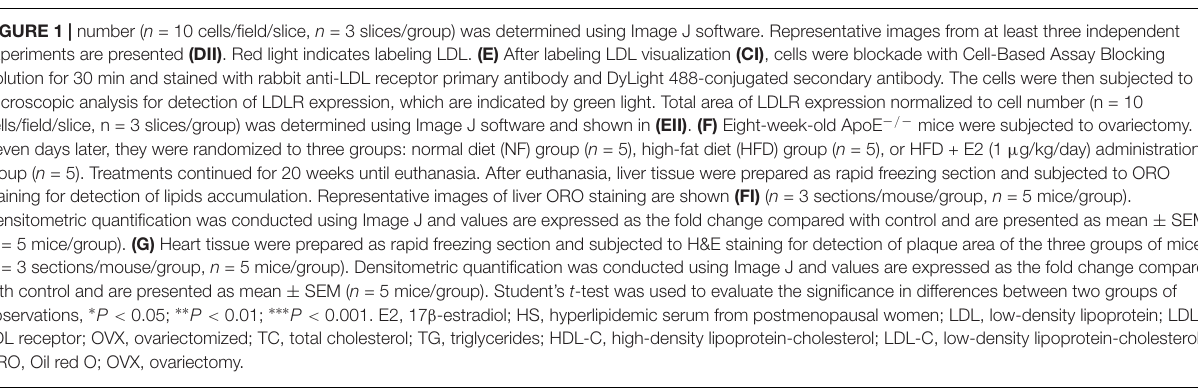
( Figure 3A ) and protein expression of ESR α and n-SREBP-1 ( Figure 3B ). Correspondingly, knockdown of ESR α expression with shRNA resulted in downregulated mRNA and protein expression of ESR α and SREBP-1. The immunofluorescence 1 and HepG2 were consistent with the WB results ( Figure 3C